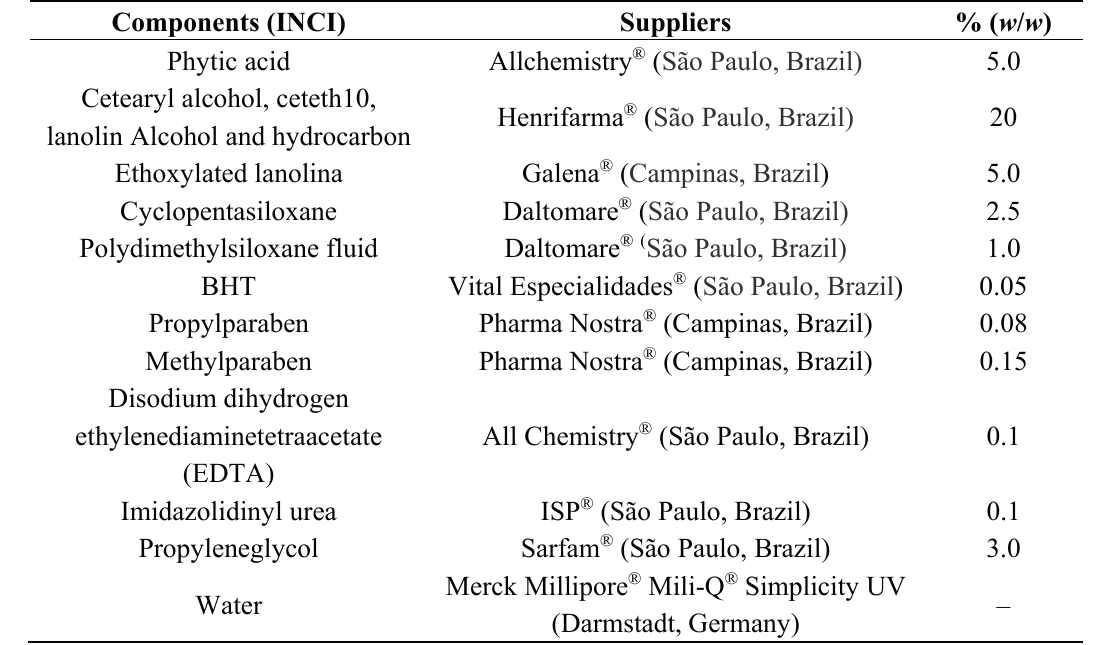
Table 1. Components, suppliers and composition (weight %) of the prepared cosmetic